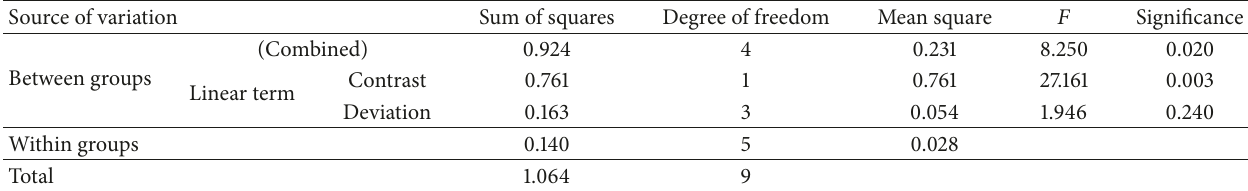
Table 4: ANOVA: single factor between the groups of different particle contents on softening point value.